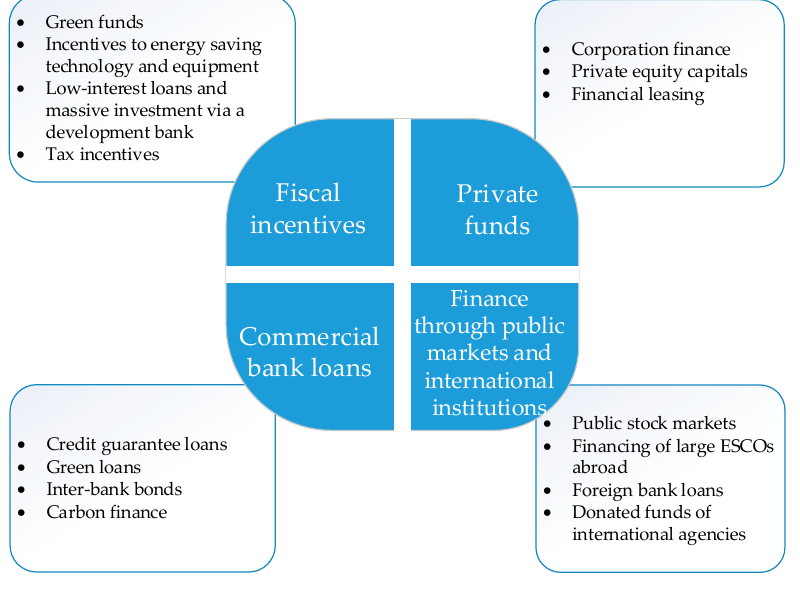
Figure 1. Primary financing sources for energy efficiency projects.